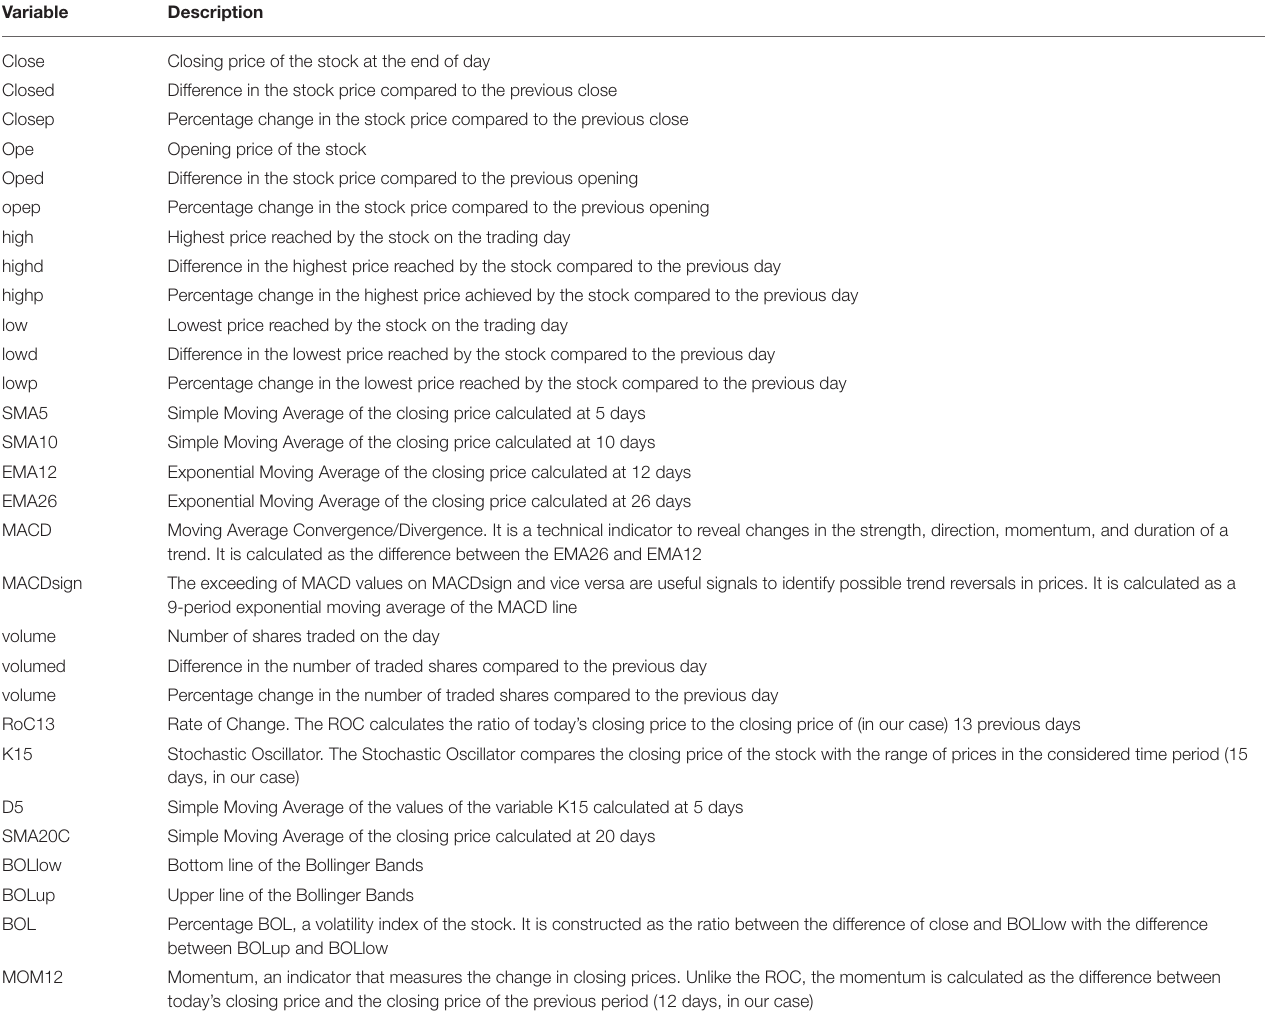
TABLE 2 | List of the variables we considered for the empirical analysis. Variable